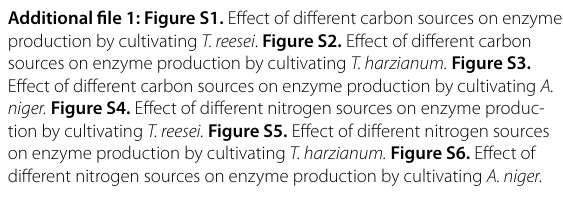
niger. Figure S4. Effect of different nitrogen sources on enzyme produc- tion by cultivating T. reesei. Figure S5. Effect of different nitrogen sources on enzyme production by cultivating T. harzianum. Figure S6. Effect of different nitrogen sources on enzyme production by cultivating A. niger. Acknowledgements Not